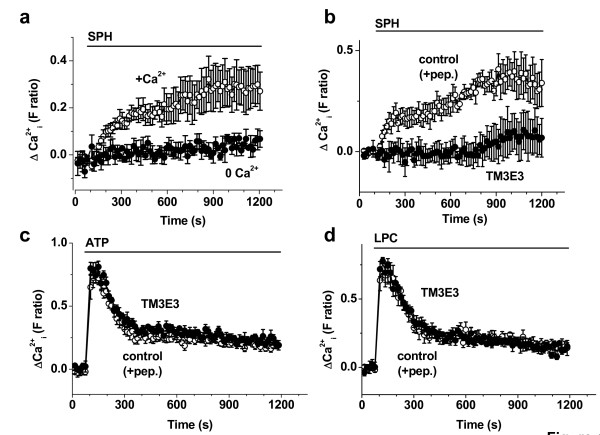
Ca2+-entry evoked by sphingosine (SPH) in primary cultures of FLSs from patients with RA. (a) Intracellular Ca2+ measurement showing the effect of external application of 20 μM SPH in the presence and absence of extracellular Ca2+. (b-d) Intracellular Ca2+ measurements showing responses to externally applied substances: (b) 20 μM SPH, (c) 100 μM adenosine triphosphate (ATP), and (d) 30 μM lysophosphatidylcholine (LPC). In paired experiments on the same 96-well plate, responses were compared after pre-treatment with anti-TRPM3 antibody (TM3E3) or TM3E3 preadsorbed to its antigenic peptide ("+pep."; control group). (a-d) All data points are N = 8 and representative of 3 (n) independent experiments.